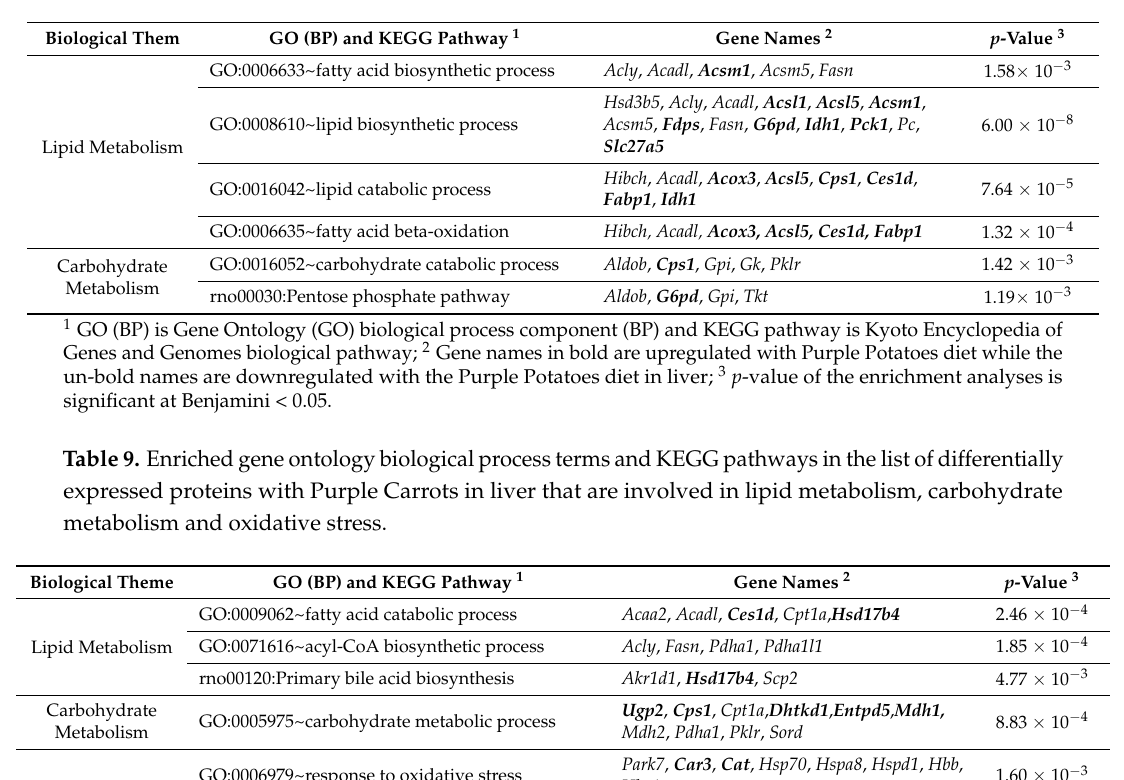
Table 8. Enriched gene ontology biological process terms and KEGG pathways in the list of differentially expressed proteins with Purple Potatoes in liver that are involved in lipid metabolism and carbohydrate metabolism.